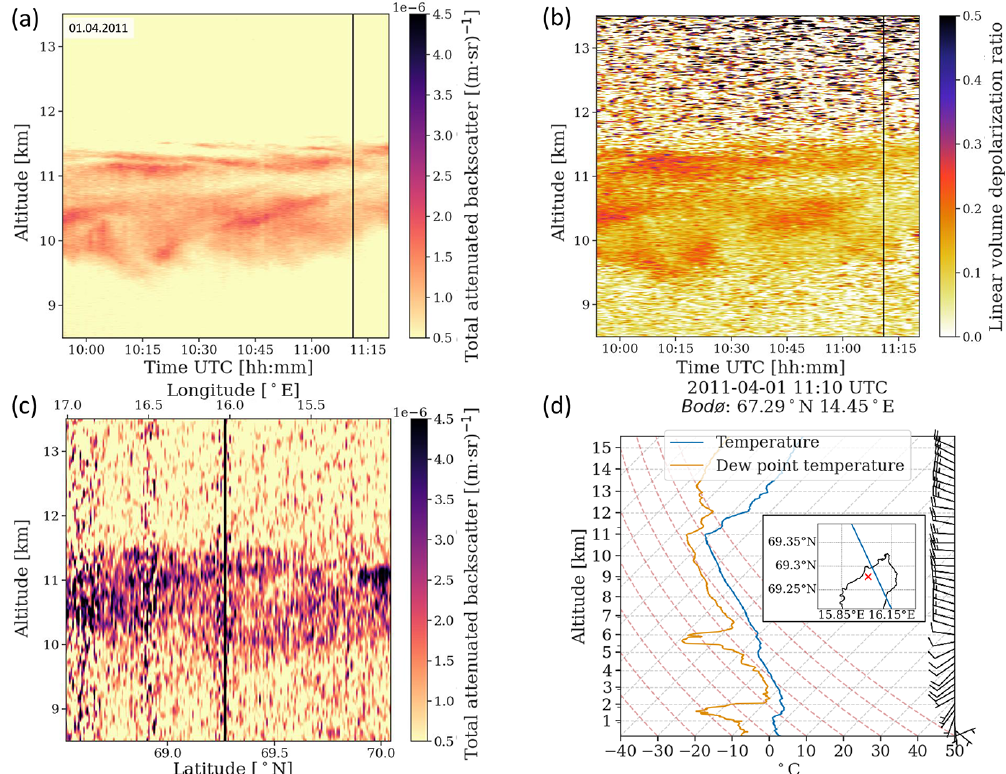
Figure 2. Cirrus cloud measurement on 1 April 2001, showing the total attenuated backscatter at 532nm from the ALOMAR lidar (a) and CALIOP (c) as well as the linear volume depolarization ratio from the ground-based lidar (b) . The closest available radiosounding from Bodø is shown in panel (d) , along with a map showing the ground track of the satellite (blue line) and the position of the ground-based lidar (red cross). The black lines show the overpass time in panels (a) and (b) and the closest location during the overpass in panel (c) . The vertical and temporal resolutions of the ALOMAR lidar are 7.5m and 67s, respectively. The satellite resolution is 60m in the vertical direction and 1km in the horizontal direction. In addition, the satellite backscatter is smoothed by a Gaussian